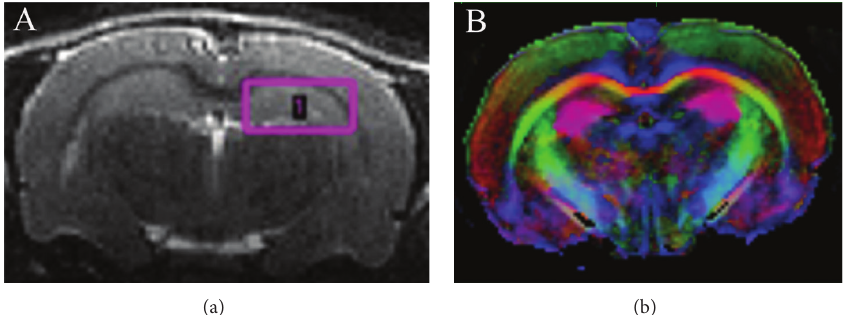
Figure 2: Data from our group indicates that measurable imaging changes precede cognitive decline. (a) An image of a rat brain acquired using a 9.4TMRI. The pink box indicates where 1 H MRS was performed. Changes in glutamate, alanine, and lactate preceded cognitive impairments. In addition, FA analysis detected a decrease in volume of the fimbria. (b) An FA map of the rat brain.